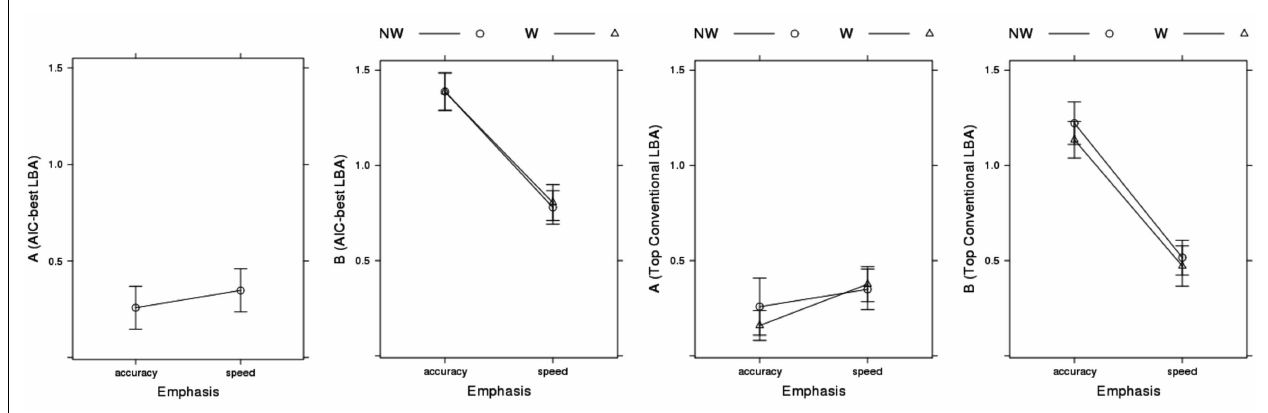
FIGURE 8 | Emphasis effects onAIC-best ( B ∼ lR ∗ E & A ∼ E & v ∼ W ∗ C & sv ∼ E ∗ C & t0 ∼ E ) and top conventional LBA model ( B ∼ lR ∗ E & A ∼ lR ∗ E & v ∼ W ∗ C & sv ∼ W ∗ C & t 0 ∼ E ) start-point noise ( A ) and boundary ( B )